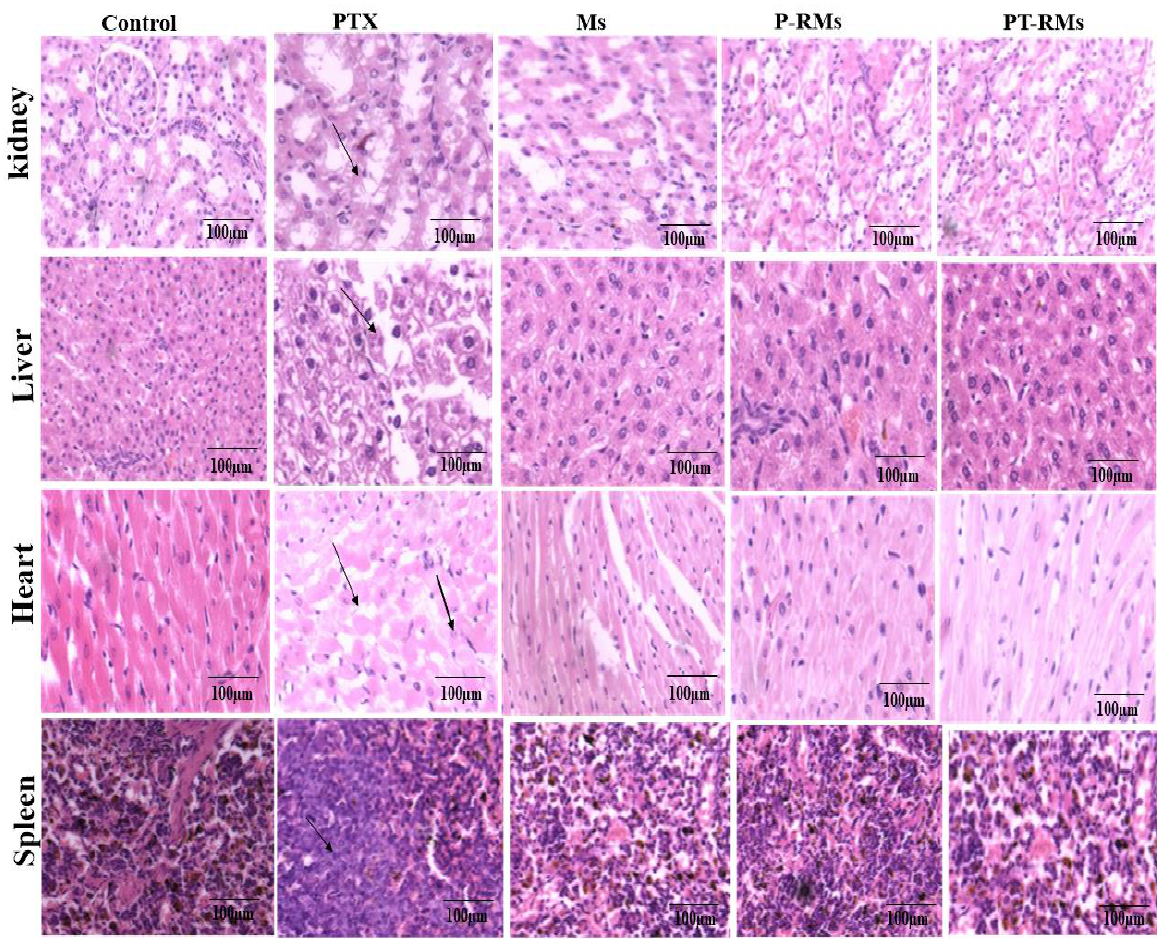
Figure 14. Histopathological changes of vital organs (spleen, heart, liver, and kidney) in H&E staining after 14 days. Pure PTX exhibited histological lesions in liver tissue, necrosis, and infiltration of inflammatory cells indicated with an arrow.